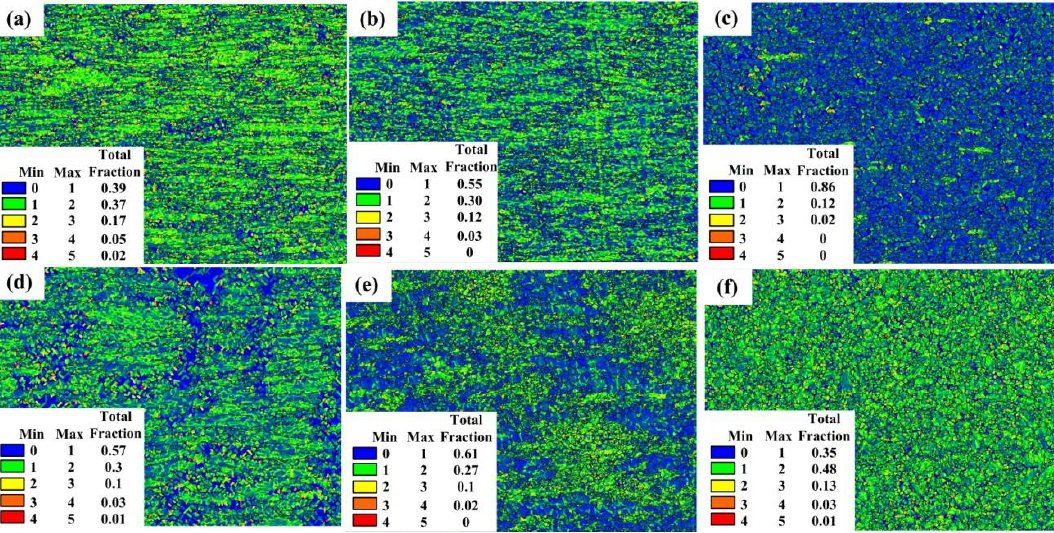
Figure 13. KAM map. ( a ) 700 °C, 1 s − 1 ( b ) 750 °C, 1 s − 1 ( c ) 800 °C, 1 s − 1 ( d ) 750 °C, 10 s − 1 ; ( e ) 800 °C, 10 s − 1 ;( f ) 850 °C, 10 s − 1 .